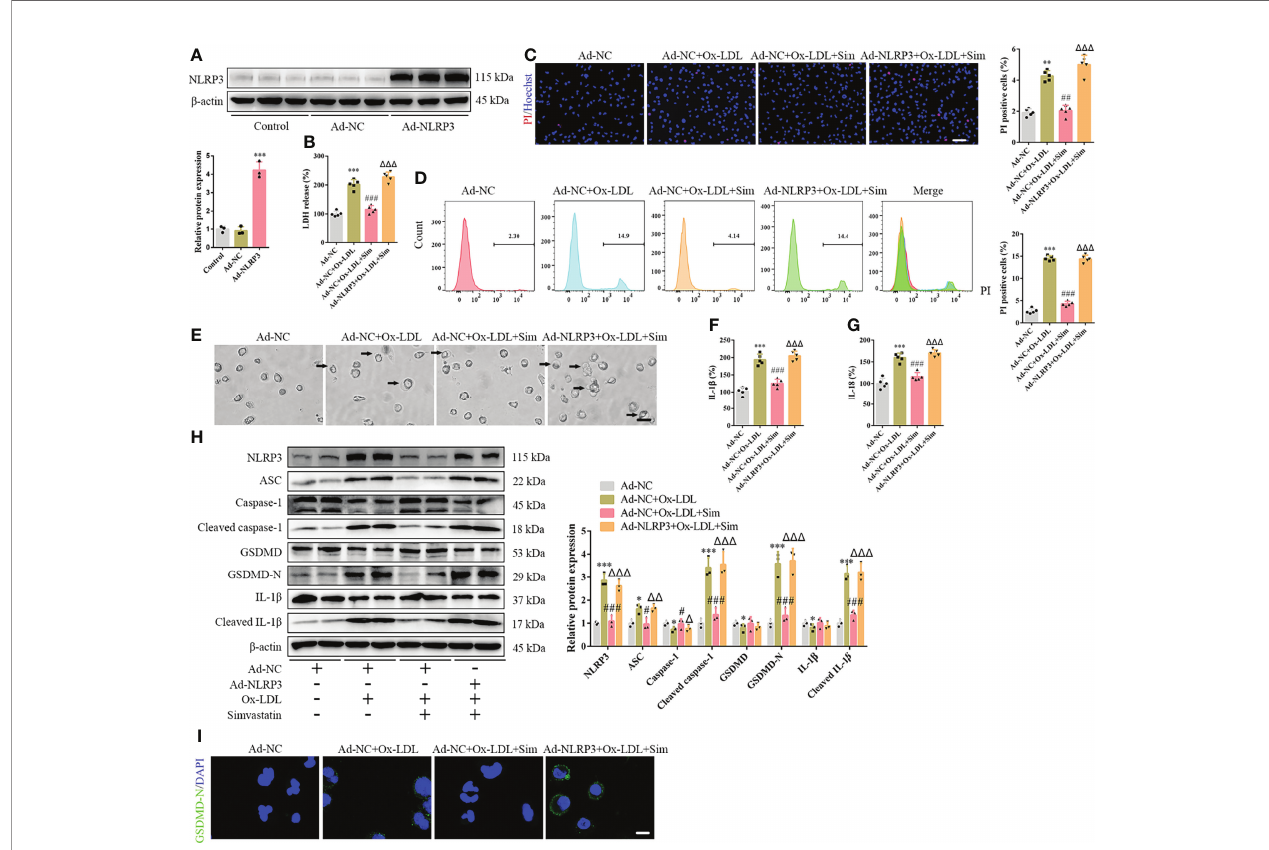
FIGURE 3 | NLRP3 overexpression reverses the effects of simvastatin on foam cell pyroptosis. (A) Western blotting showing NLRP3 overexpression. (B) Lactate dehydrogenase release in the cell supernatants. (C) Hoechst 33342 (blue) and propidium iodide (red) fl uorescence staining showing cell membrane integrity. Scale bar, 100 m m. (D) Flow cytometry to detect pyroptotic cells. (E) Pyroptotic bubbles (arrow) observed through microscopy. Scale bar, 25 m m. (F, G) Enzyme-linked immunosorbent assay for the detection of IL-1 b and IL-18 levels in the cell supernatants. (H) Western blotting showing protein abundance. (I) Immuno fl uorescence staining showing GSDMD-N activation. Scale bar, 12.5 m m. * p < 0.05, ** p < 0.01, *** p < 0.001, versus the Ad-NC + ox-LDL group. # p < 0.05, ## p < 0.01, ### p < 0.001, versus the Ad-NC + ox-LDL group. △ p < 0.05, △△ p < 0.01, △△△ p < 0.001, versus the Ad-NC + ox-LDL + sim